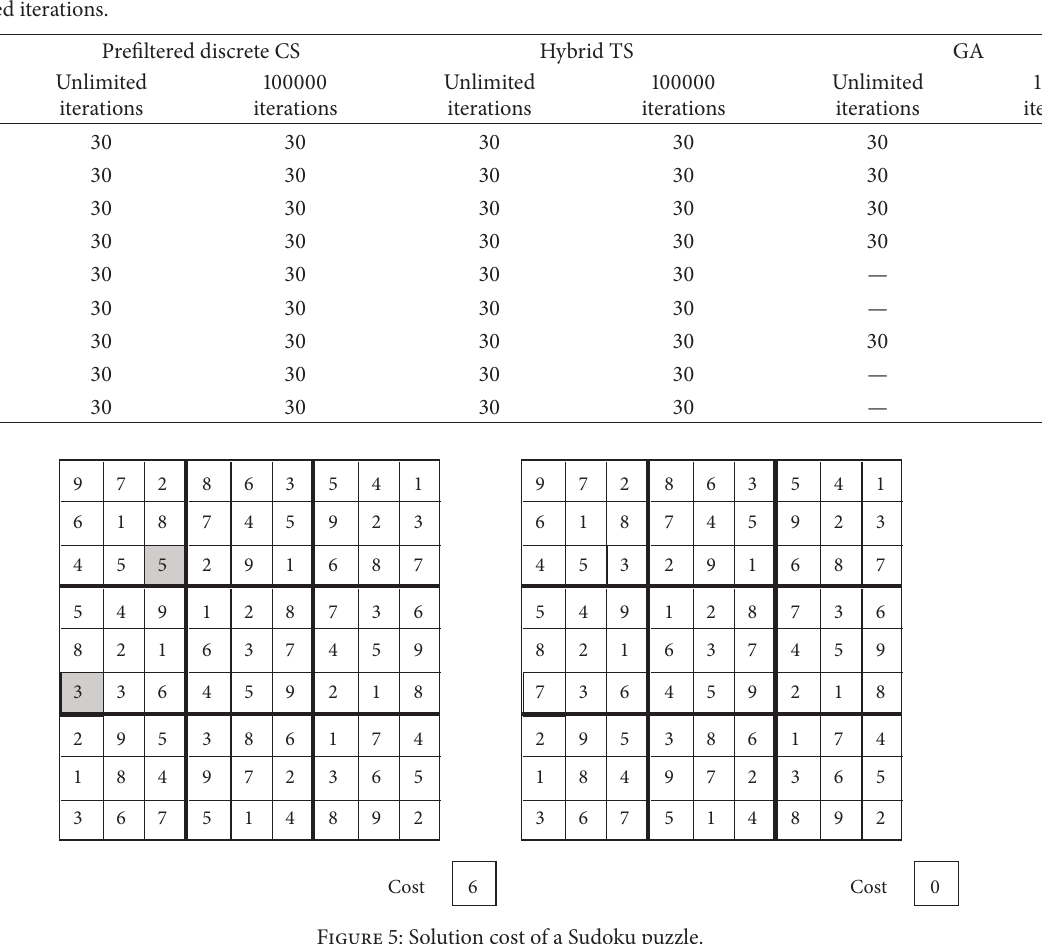
Figure 5: Solution cost of a Sudoku puzzle.